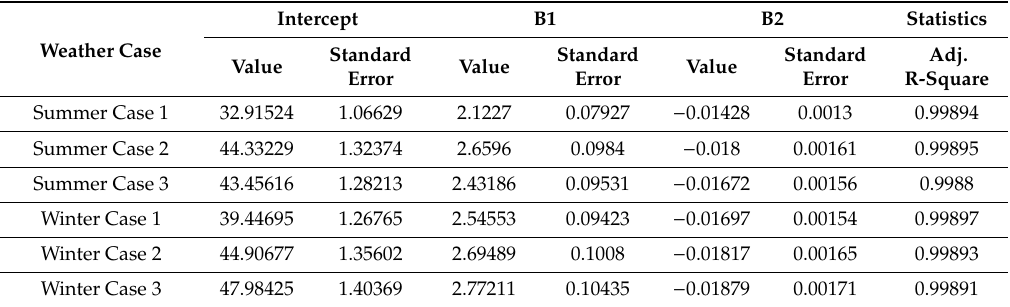
Table 8. Regression analysis results according to polynomial fitting: Simulation under summer (40 ◦ C) and winter (0 ◦ C)